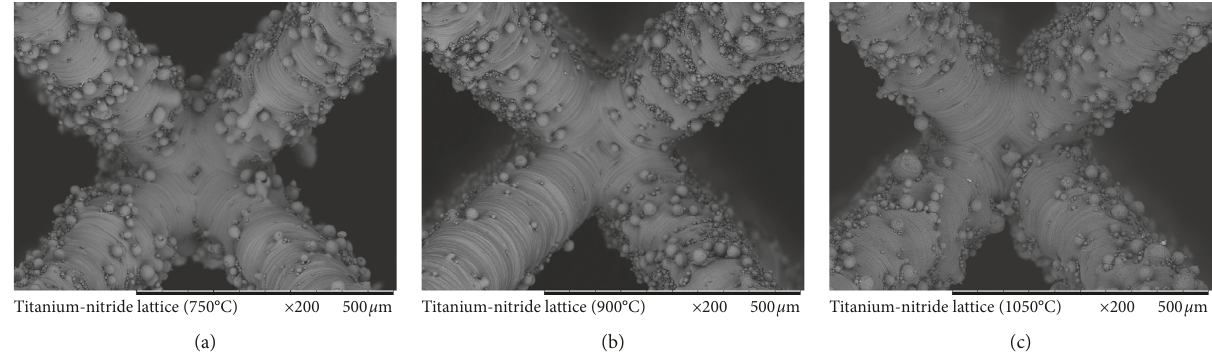
Figure 8: SEM images of Ti6Al4V lattices nitrided at various temperatures. Volume fraction and unit cell size are 15% and 1mm, respectively.